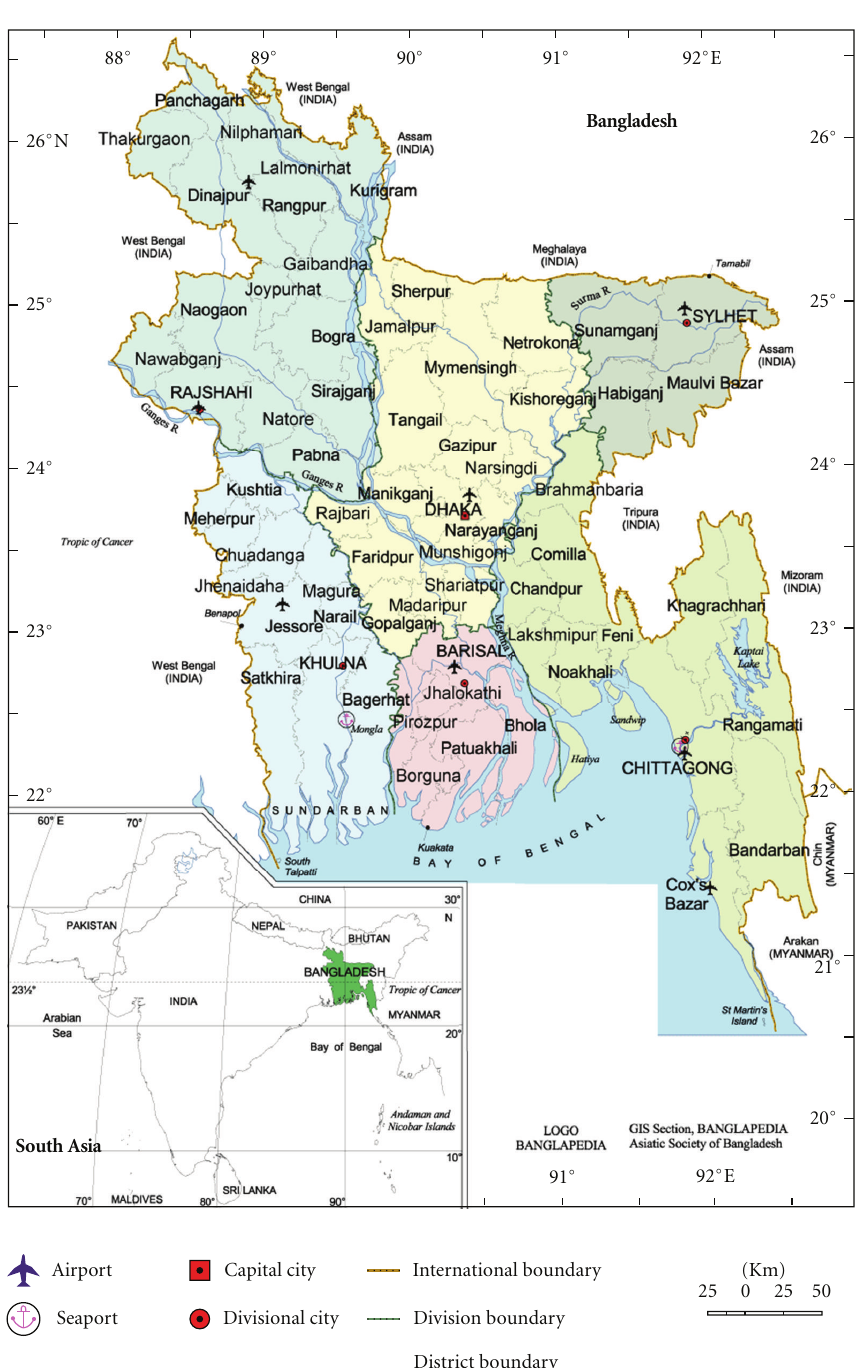
Figure 1: Map of Bangladesh and its six administrative